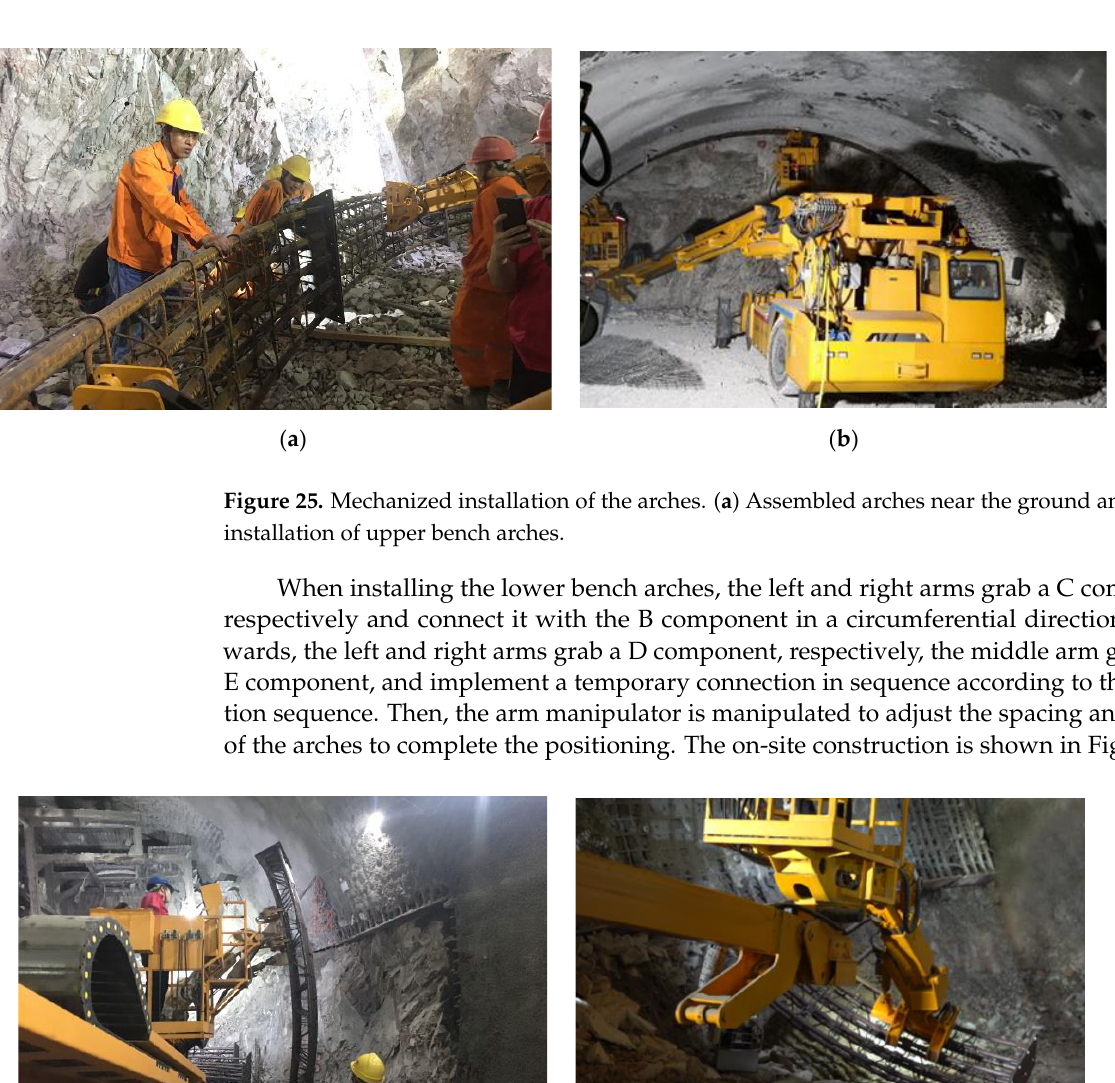
( b ) Figure 24. The preparation before construction. ( a ) Road surface treatment and ( b ) the overbreak and underbreak treatment. (2)